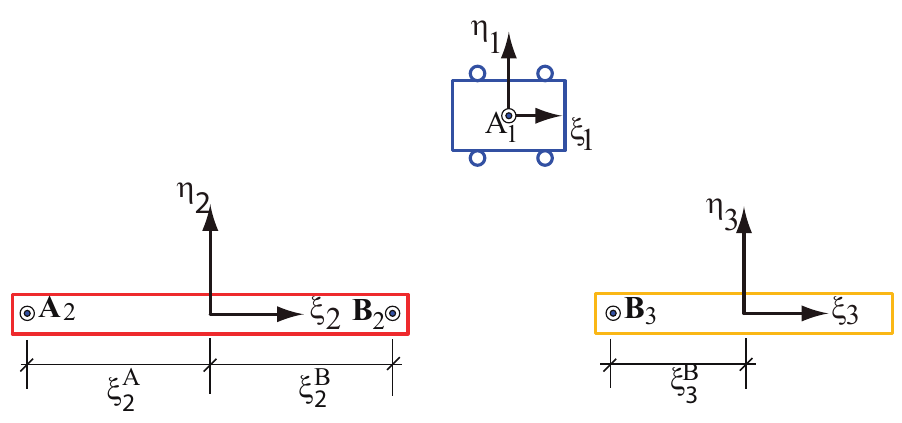
Figure 5. The multibody system viewed as an unconstrained